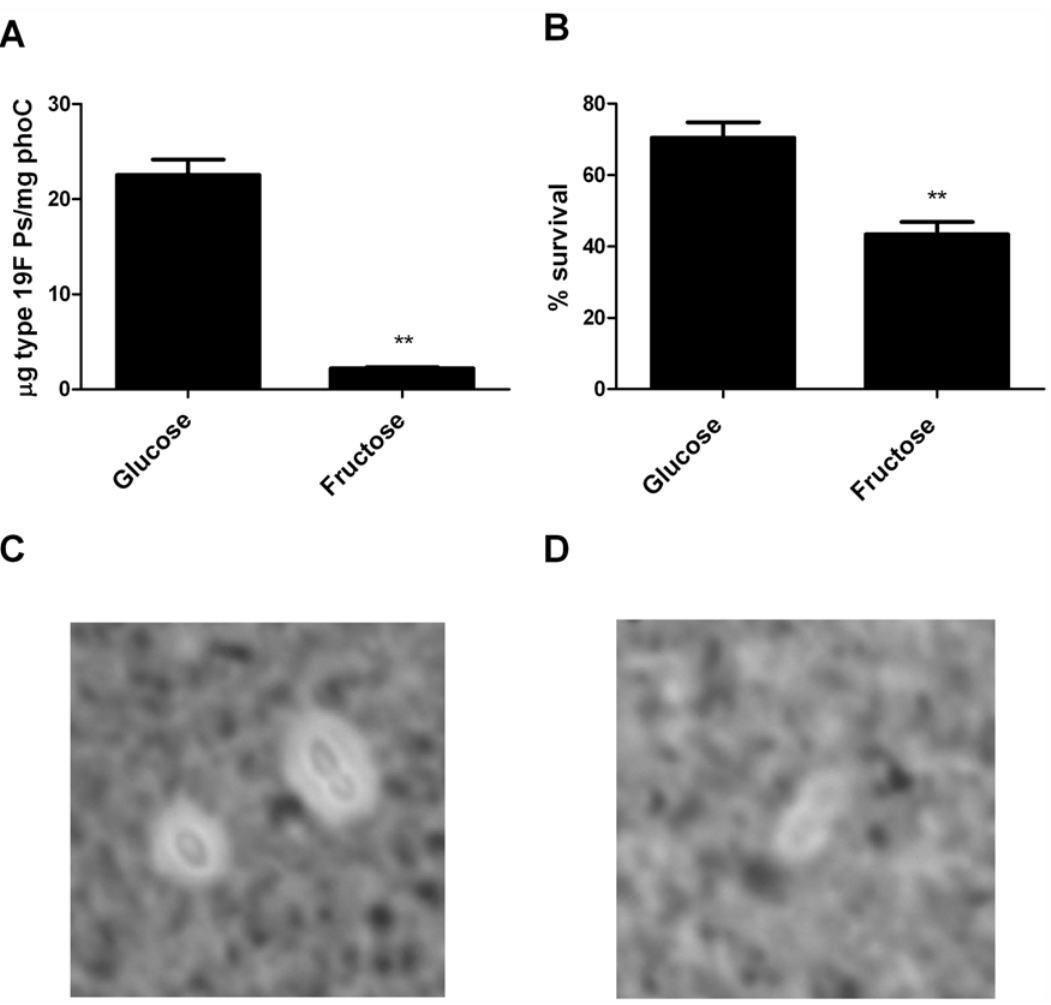
Figure 3. Effect of degree of encapsulation on susceptibility to neutrophil-mediated killing of type 19F. Growth in fructose leads to A) a decrease in cell-associated type 19F polysaccharide as evaluated by inhibition ELISA and B) decreased resistance to neutrophil-mediated killing. Mean + / 2 SEM, p , 0.001. The capsules of bacteria grown in C) glucose or D) fructose were visualized in India ink.